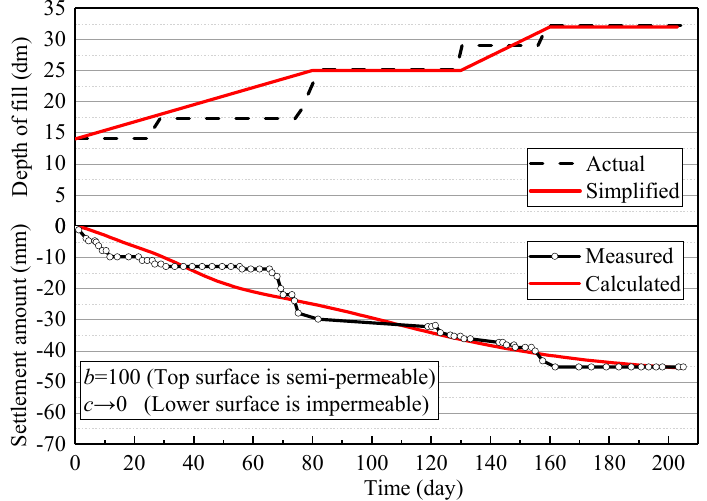
Figure 9. Comparison of measured and calculated values of settlement.